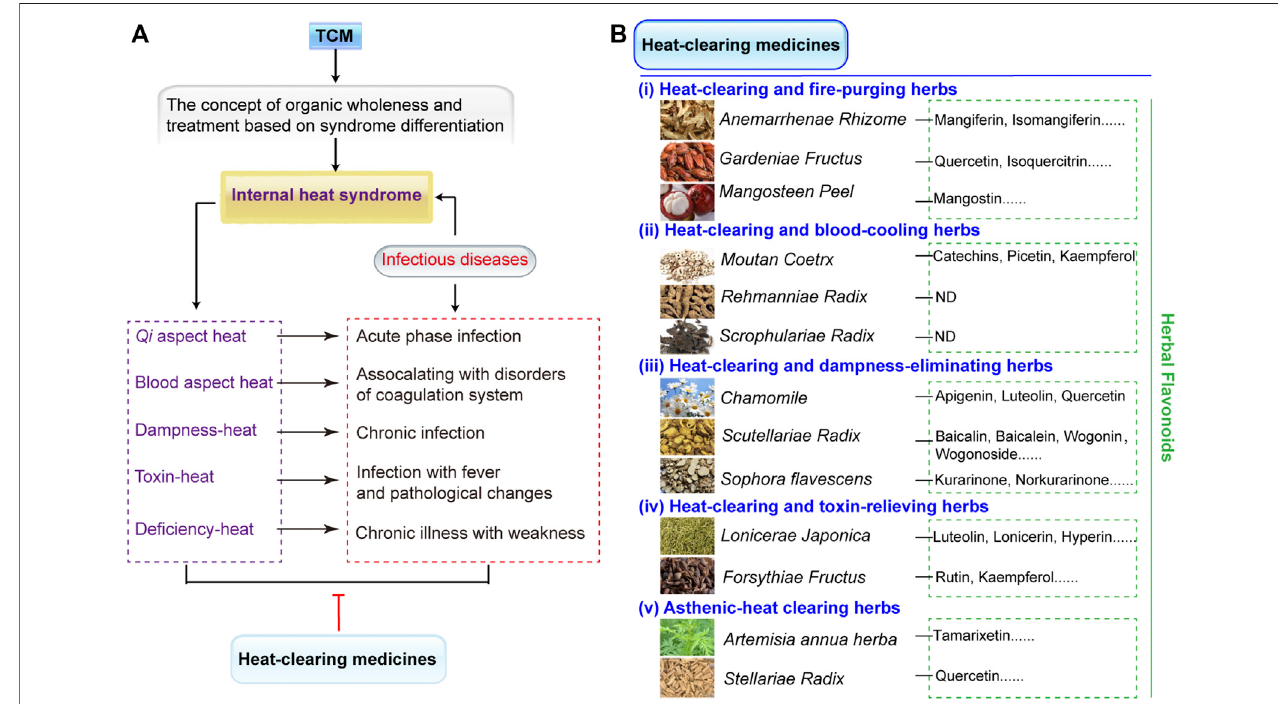
FIGURE2| Heat-clearingmedicinesandthedistributionofits fl avonoidcompounds. (A) Heat-clearingmedicinestreatinternalheatsyndrome.TCMisidenti fi edby the concept of organic wholeness and treatment based on syndrome differentiation. The syndrome differentiation of infectious diseases belongs to internal heat syndrome, which can be treated with heat-clearing medicines. Internal heat syndrome contains Qi aspect heat, blood aspect heat, dampness-heat, toxin-heat, and de fi ciency-heat and occur during the spatiotemporal axis of infectious diseases, such as acute phase, disorders of coagulation system, chronic infection, fever, pathologicalchanges,andchronicillnesswithweakness. (B) Theclassi fi cationsofheat-clearingmedicinesthatcombatdifferentheatsyndromesinclude(i)heat-clearing and fi re-purging herbs, (ii) heat-clearing and blood-cooling herbs, (iii) heat-clearing and damp-eliminating herbs, (iv) heat-clearing and toxin-relieving herbs, and (v) asthenic-heat clearing herbs. In addition, the heat-clearing herbs that contain herbal fl avonoids are listed. ND denotes no detected fl avonoids in heat-clearing herbs. All the species list in the fi gure are fully validated 3 .